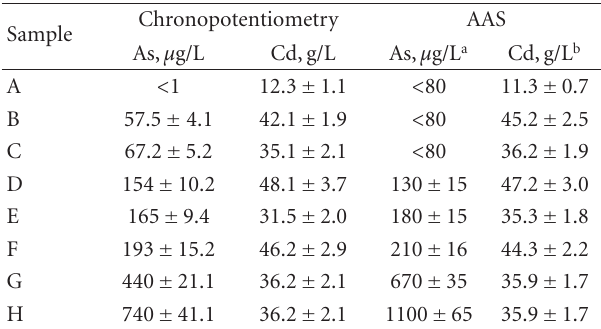
Table 4: Analyses of real